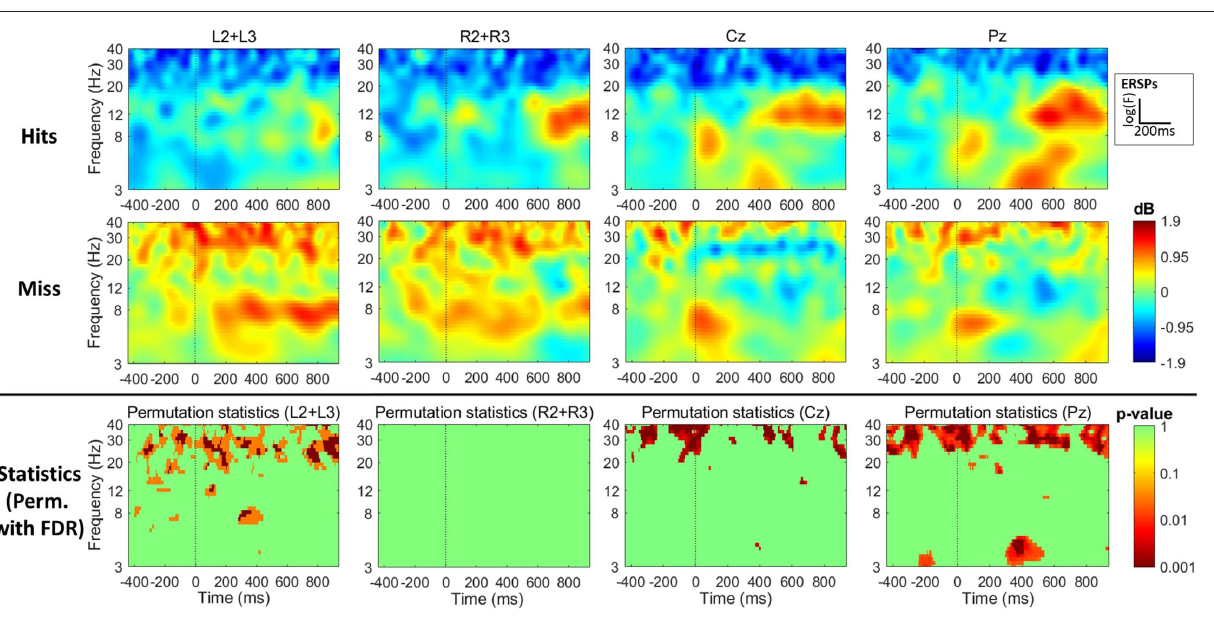
FIGURE 4 | EEG results in the time-frequency domain for the oddball task during flight simulation. Data for hits (top line) and misses (middle line), as well as the permutation statistics (FDR correction for multiple comparisons) between the two conditions, are shown for the cEEGrid recording at the left hear (average of L2 and L3–first column) and the right hear (average of R2 and R3–second column), and the Enobio recording at Cz (third column) and Pz (fourth column) electrodes. All data (except statistics) are presented as the average power (in dB) increase (red data) or decrease (blue data) relative to baseline with a common baseline across conditions (hits vs. miss) for each electrode or electrode average. Statistics (third line) show the statistical significance as obtained with the p − value revealing a significant difference (red) or not (green) between the compared conditions (hits vs. misses). The x-axis shows the time course of data across the 250 time-points selected in a − 442 to 938 ms time-window centered on stimulus display ( t = 0). The y-axis shows the frequency range (log-scale between 3 and 40 Hz) across which 40 frequencies were selected for wavelet